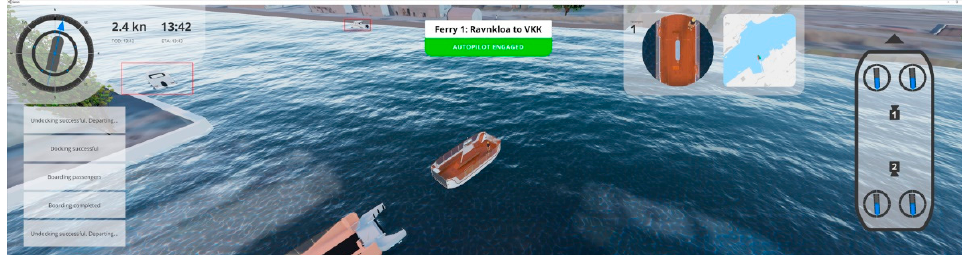
Figure 14. Collision avoidance of the ASV Telemetron: ( Left ) The vessel avoids collision, but the path is jagged, disjointed, and unpredictable. This undermines the trust of the crew, operators, passengers, and other vessels in the environment. ( Right ) Telemetron avoids collision with a smooth and predictable path. Crew, operators, passengers, and other vessels trust the autonomous vessel.